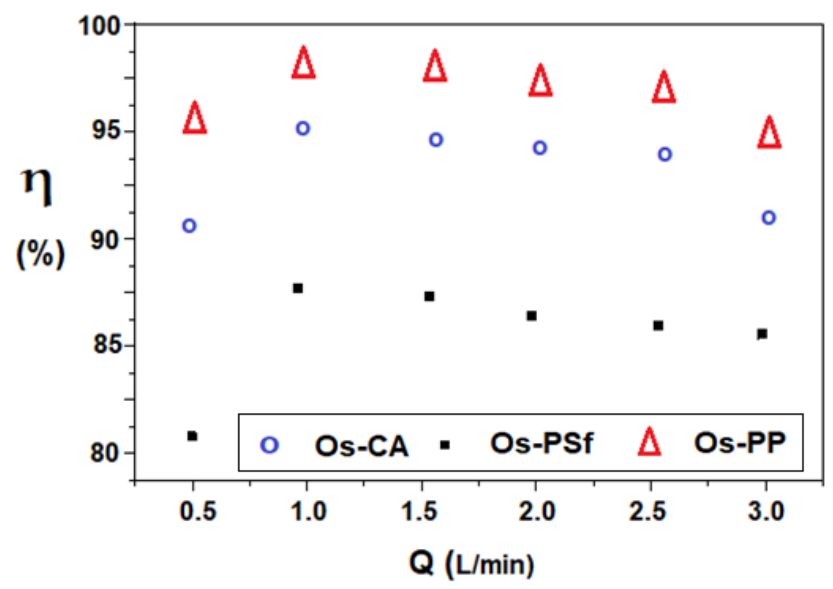
Figure 17. Variation of the conversion of 5–aminobenzimidazol according to the molecular hydrogen flow through the installation, for the prepared osmium–polymer (Os–P) membranes.